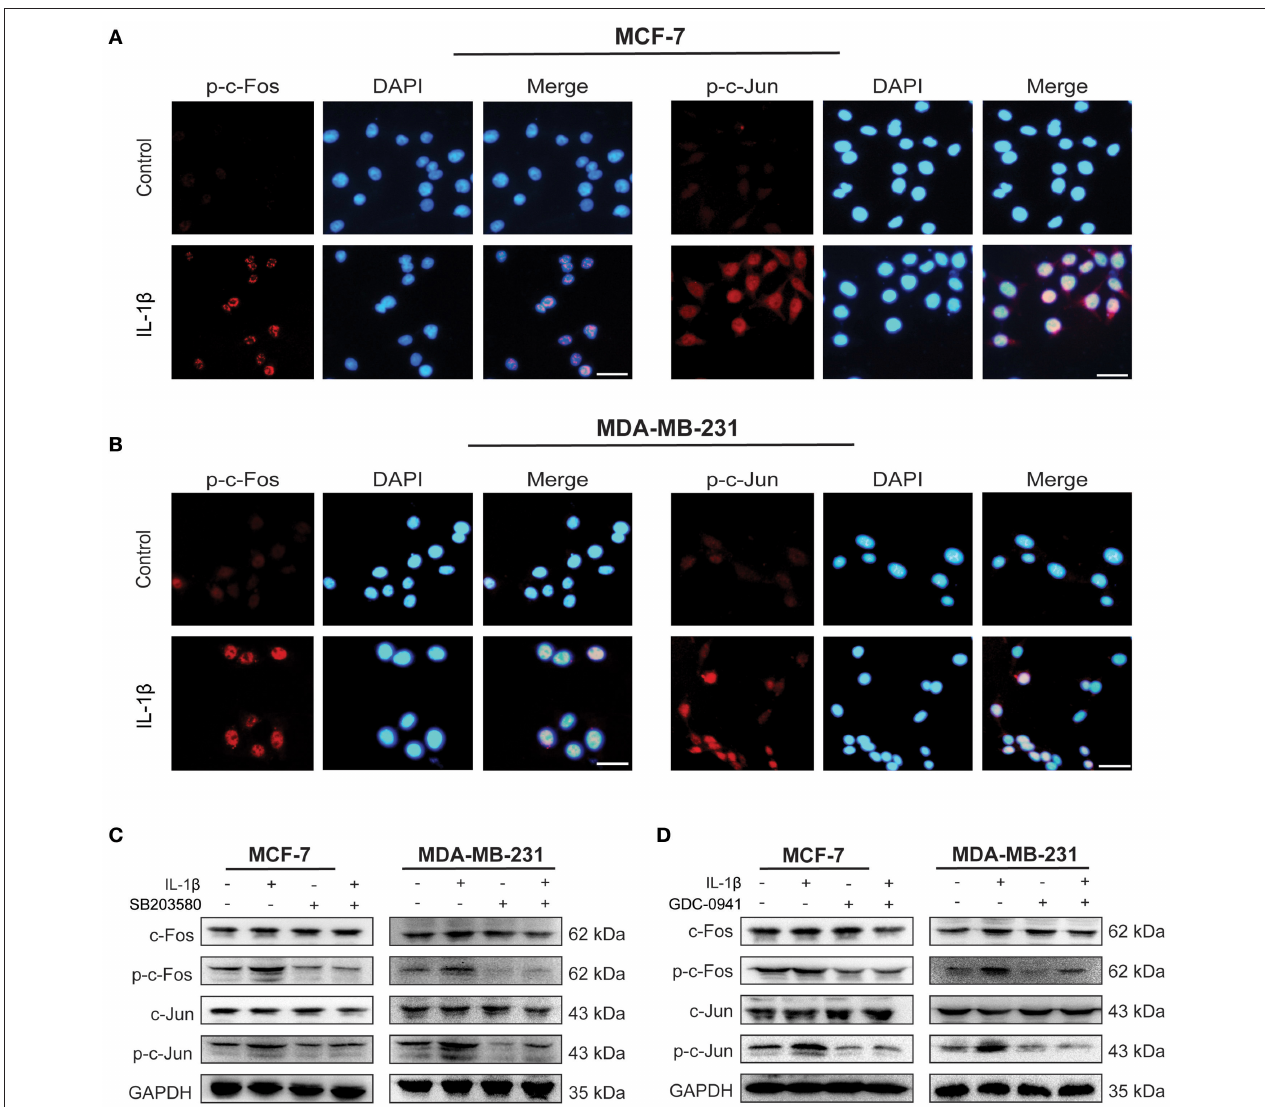
FIGURE 5 | IL-1 β activates AP-1 complex (c-Fos/c-Jun) in breast cancer cells. (A,B) Immunofluorescent staining of p-c-Fos and p-c-Jun in cells treated with IL-1 β (Scale bar: 20 µ m). (C) Western blot analysis of AP-1 complex (c-Fos/p-c-Fos and c-Jun/p-c-Jun) after cells treated with IL-1 β and SB203580. (D) Western blot analysis of AP-1 complex in cells treated with IL-1 β and GDC-0941. Statistical analysis (C,D) is represented in Supplementary Figure 2